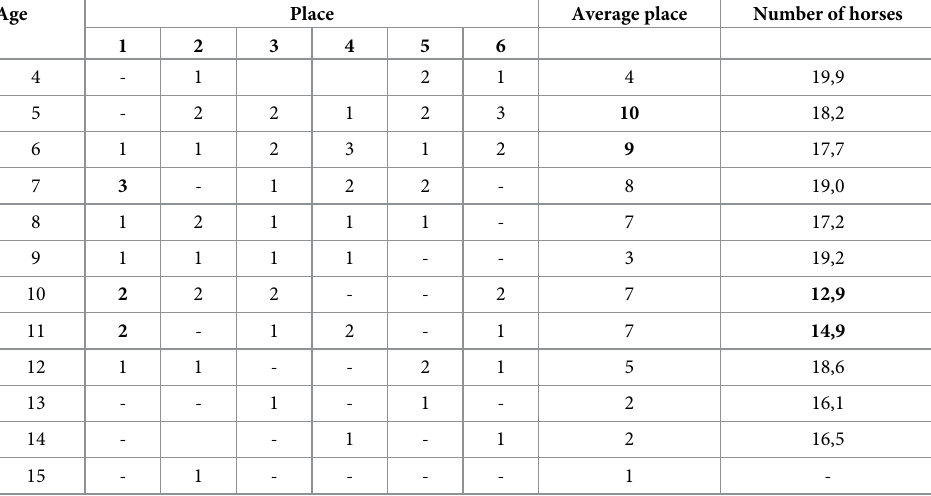
Table 1. Summary of position occupied by horses, according to age. Place Average